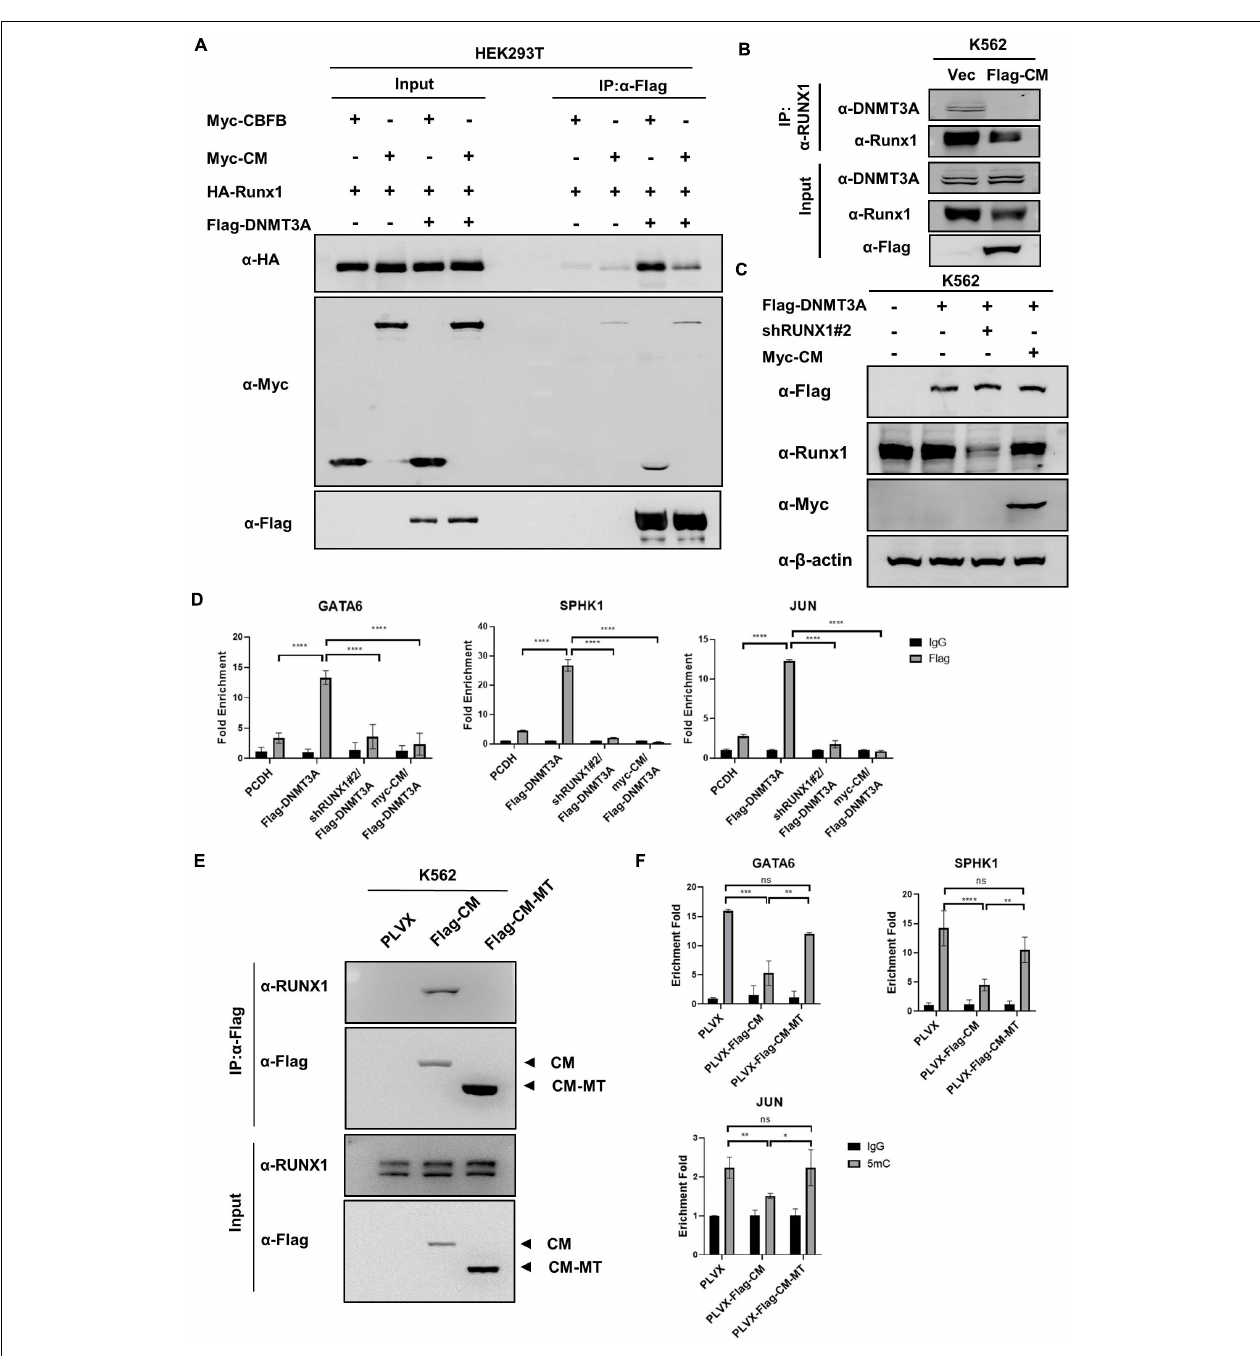
FIGURE 6 | CBFB-MYH11 mutation disrupts the interaction between DNMT3A and RUNX1. (A) CBFB-MYH11 fusion protein disrupted the interaction between DNMT3A and RUNX1. The indicated proteins were expressed in HEK293T cells. DNMT3A was purified by immunoprecipitation with Flag beads, followed by Western blot with antibodies against HA or Myc. (B) The interaction between DNMT3A and RUNX1 was impaired in CBFB-MYH11 expressing cells. Endogenous RUNX1 protein in K562 cells or CBFB-MYH11 expressing cells was immunoprecipitated and DNMT3A was detected with the specific antibody. (C) Expression of CBFB-MYH11 fusion protein or knockdown of RUNX1 in K562 cells stably expressing DNMT3A. Protein expression level was determined by Western blot. (D) DNMT3A binding to GATA6, SPHK1 and JUN genes was hindered by either RUNX1 knocking-down or CBFB-MYH11. The occupancy of DNMT3A on target genes was determined by ChIP-qPCR. Rabbit IgG was used as a negative control. Data are shown as mean ± SEM from experiments performed in triplicate. Asterisks denote statistical significance with two-way ANOVA. **** p < 0.0001 for the indicated comparison. (E) CBFB-MYH11-MT does not interact with RUNX1. Flag tagged CBFB-MYH11 (Flag-CM) or CBFB-MYH11-MT (Flag-CM-MT) was immunoprecipitated with Flag beads and RUNX1 binding was detected with antibody against RUNX1. (F) CBFB-MYH11 relies on RUNX1 to regulate DNA methylation. 5 mC level was determined by MeDIP-qPCR. Mouse IgG was included as a negative control. Data are shown as mean ± SEM from experiments performed in triplicate. Asterisks denote statistical significance with two-way ANOVA. * p < 0.05; ** p < 0.01; *** p < 0.001.